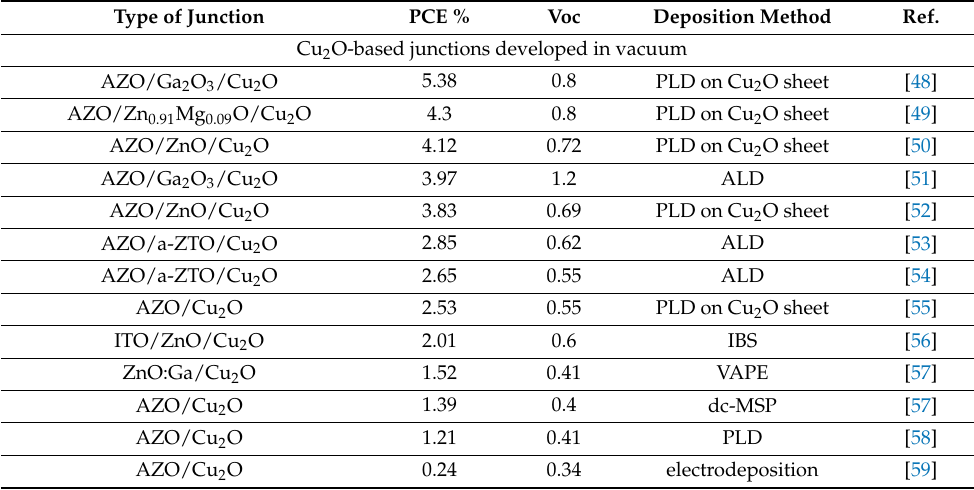
Table 1. Cu 2 O-based solar cell efficiency latest developments (until 2014). This table is based on that proposed by Ievskaya et al.